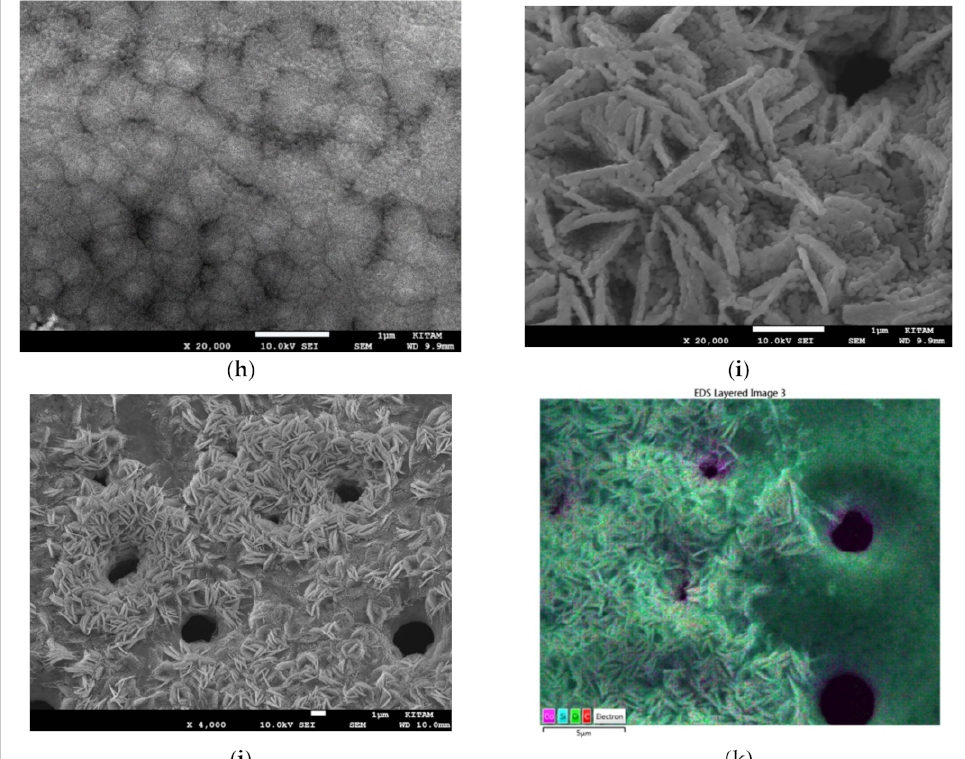
Figure 20. Analysis of the Co / Si = 1 catalyst region where the cobalt concentration is above that of the catalyst particle illustrated in Figure 18. EDS and SEM images of the Co / Si = 1 catalyst surface with higher-than-average cobalt concentration are presented. ( a ) EDS-image with the sites of the spot-EDS analysis (#2–#9); ( b ) Co-mapping; ( c ) Si-mapping; ( d ) O-mapping; ( e ) Spectrum of the site (#2)with the lowest cobalt with [Co] = 0.496; [Si] = 0.126; [O] = 0.378; ( f ) Spectrum of the main location shown in ( a ) with [Co] = 0.720; [Si] = 0.068; [O] = 0.212; ( g ) Spectrum of the site (#8) with the highest cobalt concentration where [Co] = 0.908; [Si] = 0.018; [O] = 0.074; ( h ) SEM of the site with the lowest cobalt concentration (Site #2); ( i ) SEM image with the highest cobalt concentration (Site #8); ( j ) SEM image of the regions with the high and low cobalt regions; (scale bar = 1 µ m in h–j); ( k ) EDS image of an area with and without surface decorations showing the volcanic activity around the holes where silica is absent but cobalt is dominant, (scale bar = 5 µ